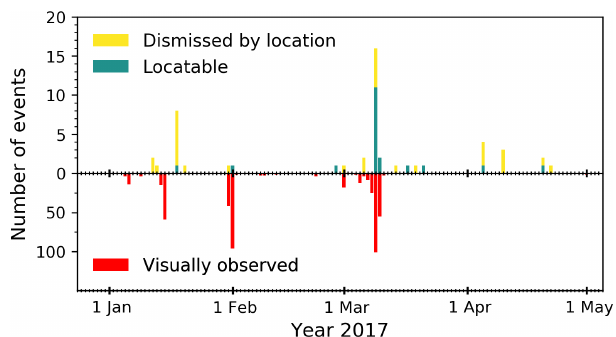
Figure 12. Turquoise bars are the number of events per day that are locatable and are considered to be avalanches. Yellow bars are the number of events per day which could not be located and were therefore dismissed. Red bars are the number of avalanches visually observed in the Davos area.